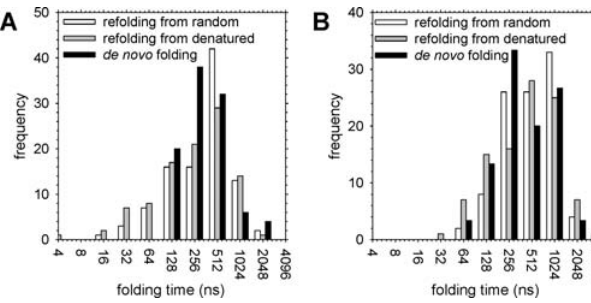
Figure 6. Simulated Kinetics of Refolding and De Novo Folding for CI2 and Barnase (A) Histograms of folding times obtained from refolding and de novo folding trajectories for CI2. (B) Same as (A), but for barnase. DOI: